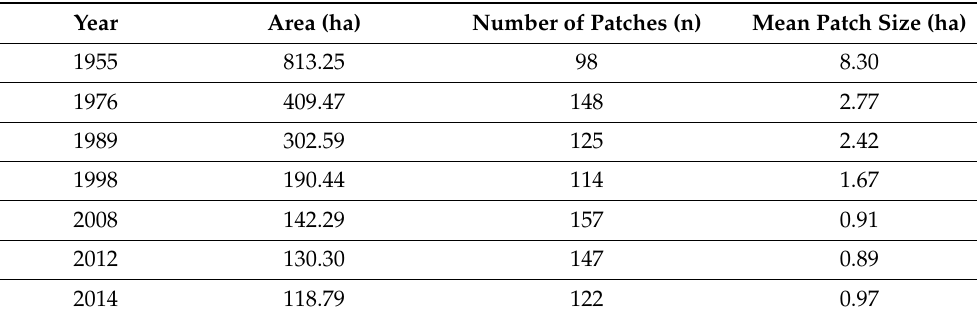
Table 3. The extent of active agricultural terraced areas, number of patches (NP), and mean patch size (MPS) for each analysed